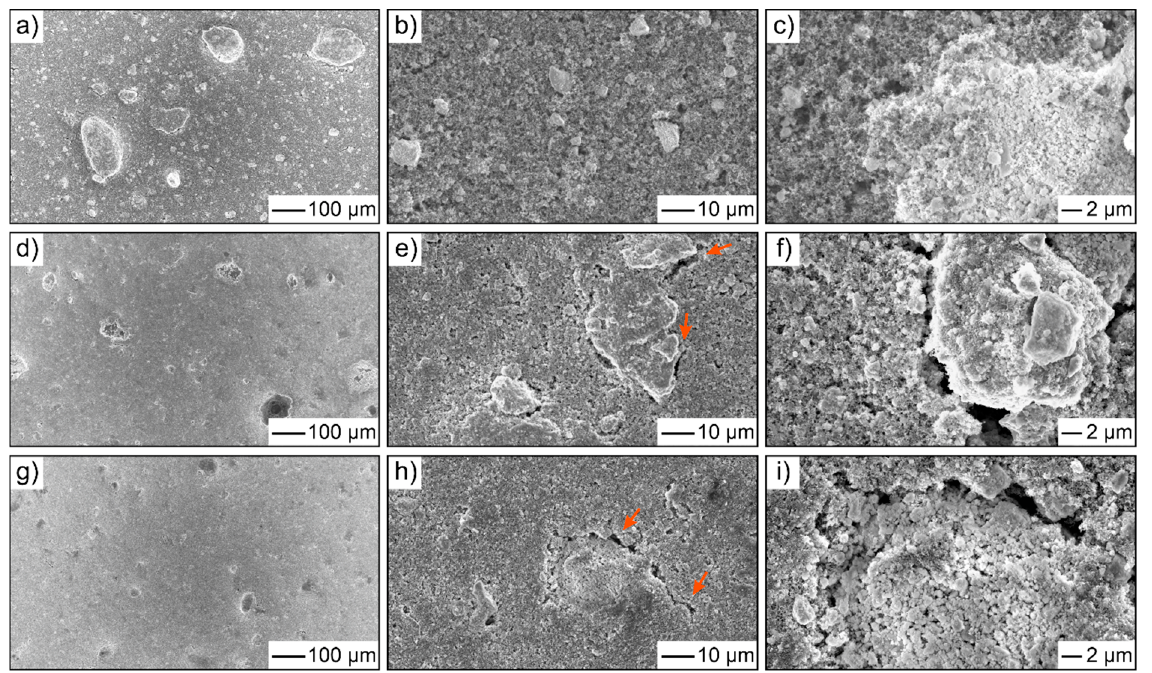
Figure 2. Top-view SEM images at different magnifications of the LiHEOF cathode ( a – c ) before cycling, ( d – f ) at 3.7 V and ( g – i ) at 4.2 V vs. Li + /Li in the initial charge cycle. The arrows indicate void formation and electrode cracking.